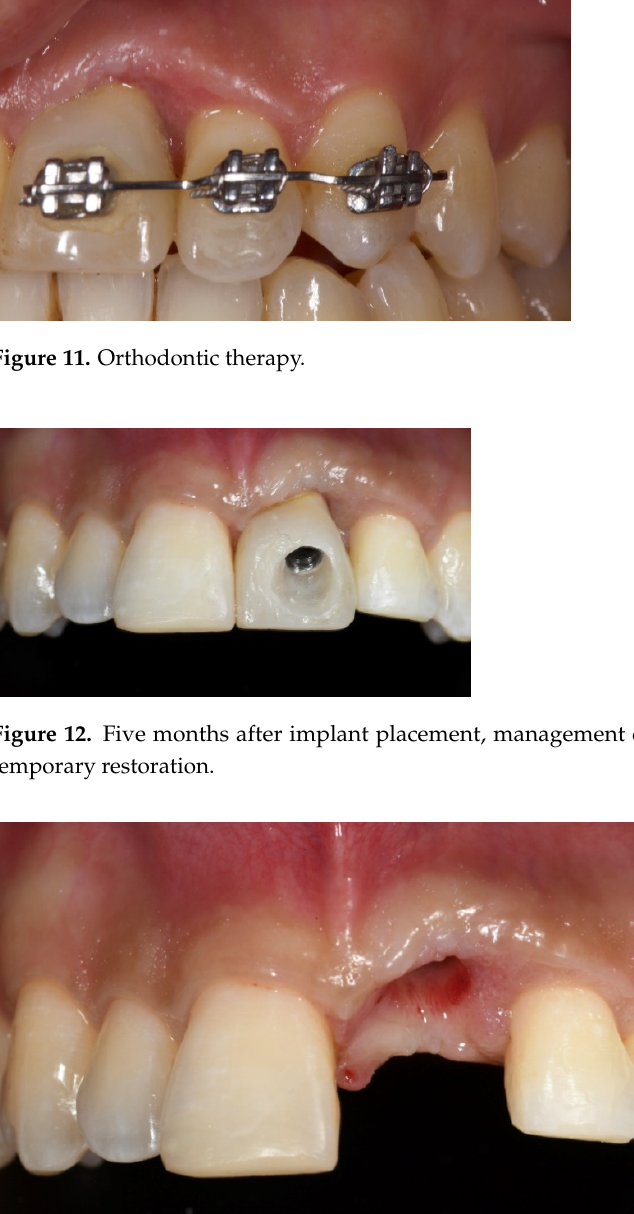
Figure 13. Five months after implant placement, management of soft tissue with screw- retained temporary restoration (without crown).